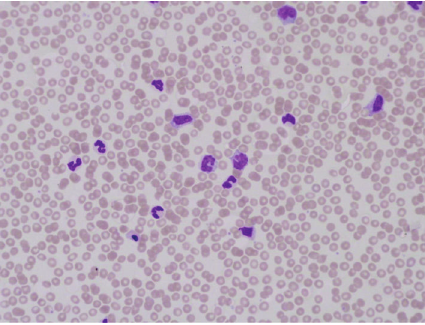
Figure 3: CT scan of the abdomen showing massive splenomegaly and bilateral plexiform neurofibromas along the psoas muscles.